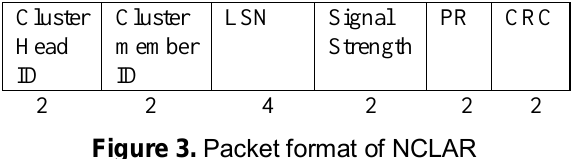
Figure 3. Packet format of